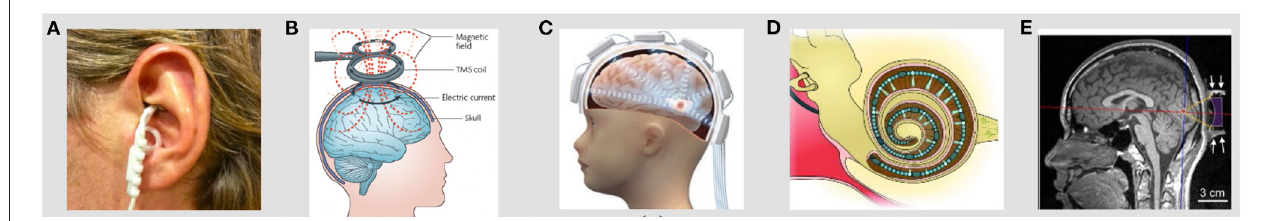
FIGURE 1 | Illustrations of exemplar technologies in energy-based therapeutic domains: (A) electrical stimulation of vagus nerve (28); (B) transcranial magnetic stimulation of brain (29); (C) microwave hyperthermia of brain (30); (D) optical stimulation of cochlea with near infrared light (31); (E) brain stimulation with focused ultrasound (FUS)